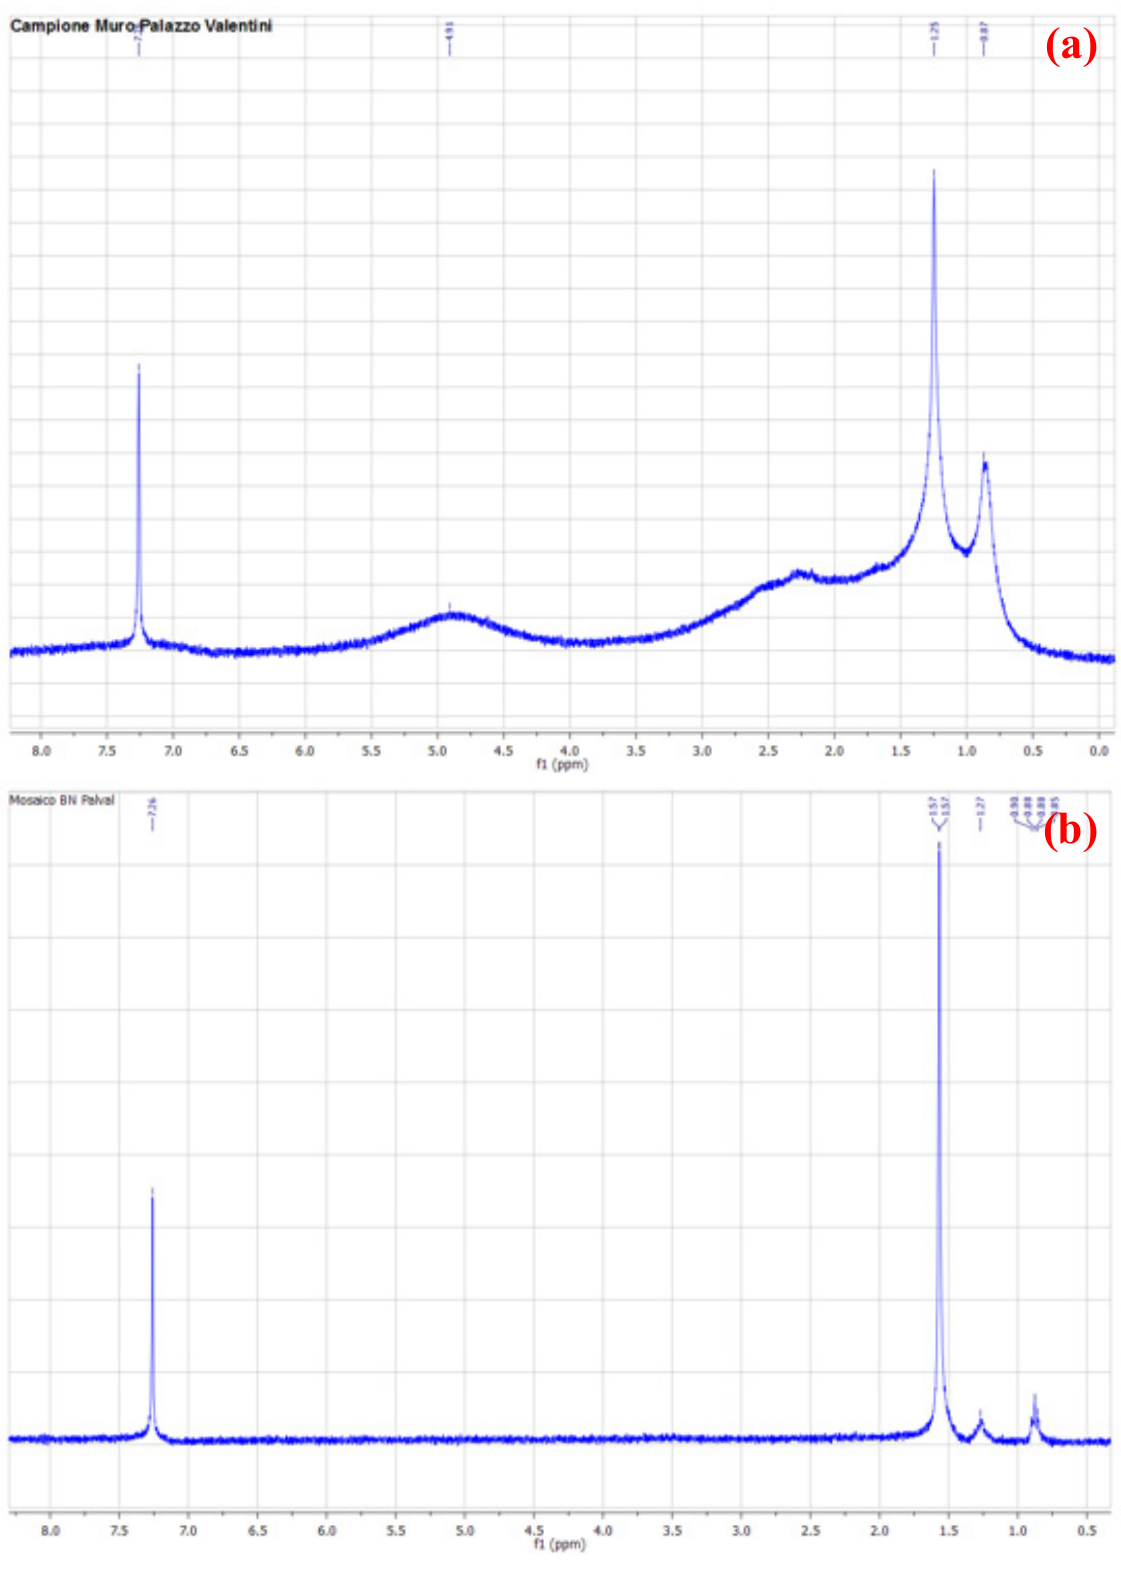
Figure 7. 1 H-NMR spectra (300 MHz, CDCl 3 ) of ( a ) wall and ( b ) pavement samples.